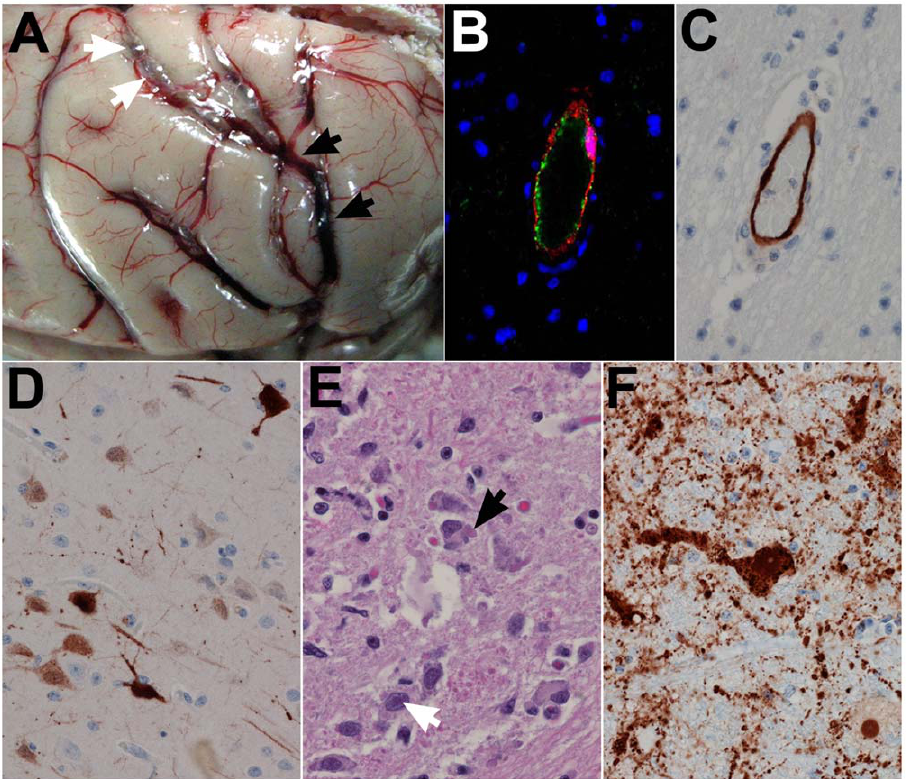
Figure 4. NiV infection and pathogenesis in the brain. Subject 3 that succumbed on day 11 after i.t. and oral exposure to 8.1 6 10 4 pfu of NiV. (A) Brain, severe congestion (black arrows) with possible meningeal hemorrhage; fluid (white arrows) suggests mild to moderate meningeal edema; (B) brain, cerebrum, double labeling for an endothelial cell marker (von Willebrand’s factor) (green) and NiV antigen (red) showing co-localization of NiV with the endothelium. Immuofluorescence method with DAPI counterstain; 400 6 magnification. Subject 6 that succumbed on day 10 after i.t. challenge with 2.3 6 10 4 pfu of NiV; (C) brain, cerebrum (corpus striatum), localization of NiV antigen by immunohistochemistry, immunopositive cells (brown) associated with the endothelium; 400 6 magnification. Subject 8 that succumbed on day 12 after i.t. challenge with 2.5 6 10 3 pfu of NiV; (D) brain, cerebrum (frontal cortex), localization of NiV antigen by immunohistochemistry, strong cytoplasmic and nuclear immunopositive neurons and processes. (E) Subject 6 brain stem and neurons with intranuclear inclusion bodies (white arrow) and intracytoplasmic inclusion bodies (black arrow), H&E staining; 400 6 magnification. Subject 5 that succumbed on day 11 after i.t. exposure to 5.9 6 10 4 pfu of NiV; (E) brain stem immunohistochemistry staining of NiV antigen in same area as in (D) with antigen detected in neuron cell body and axon as well as surrounding